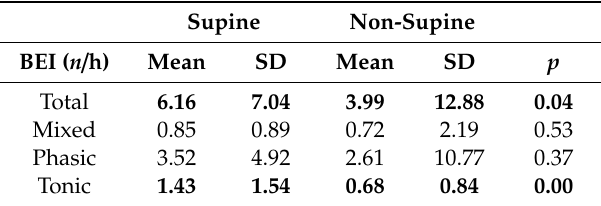
Table 6. Impact of the body position on bruxism